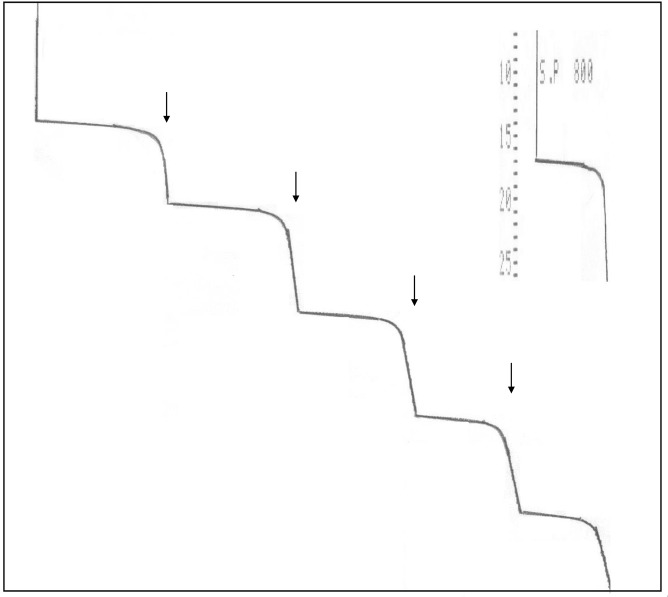
The hydrodynamic response of the GOD-CHIT/PT in a stirred phosphate buffer (0.1 M, pH 6) upon injection of 1.5 mM glucose each step.